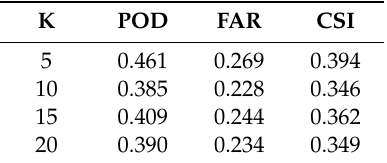
Table 2. The POD, FAR and CSI for di ff erent k values in the same